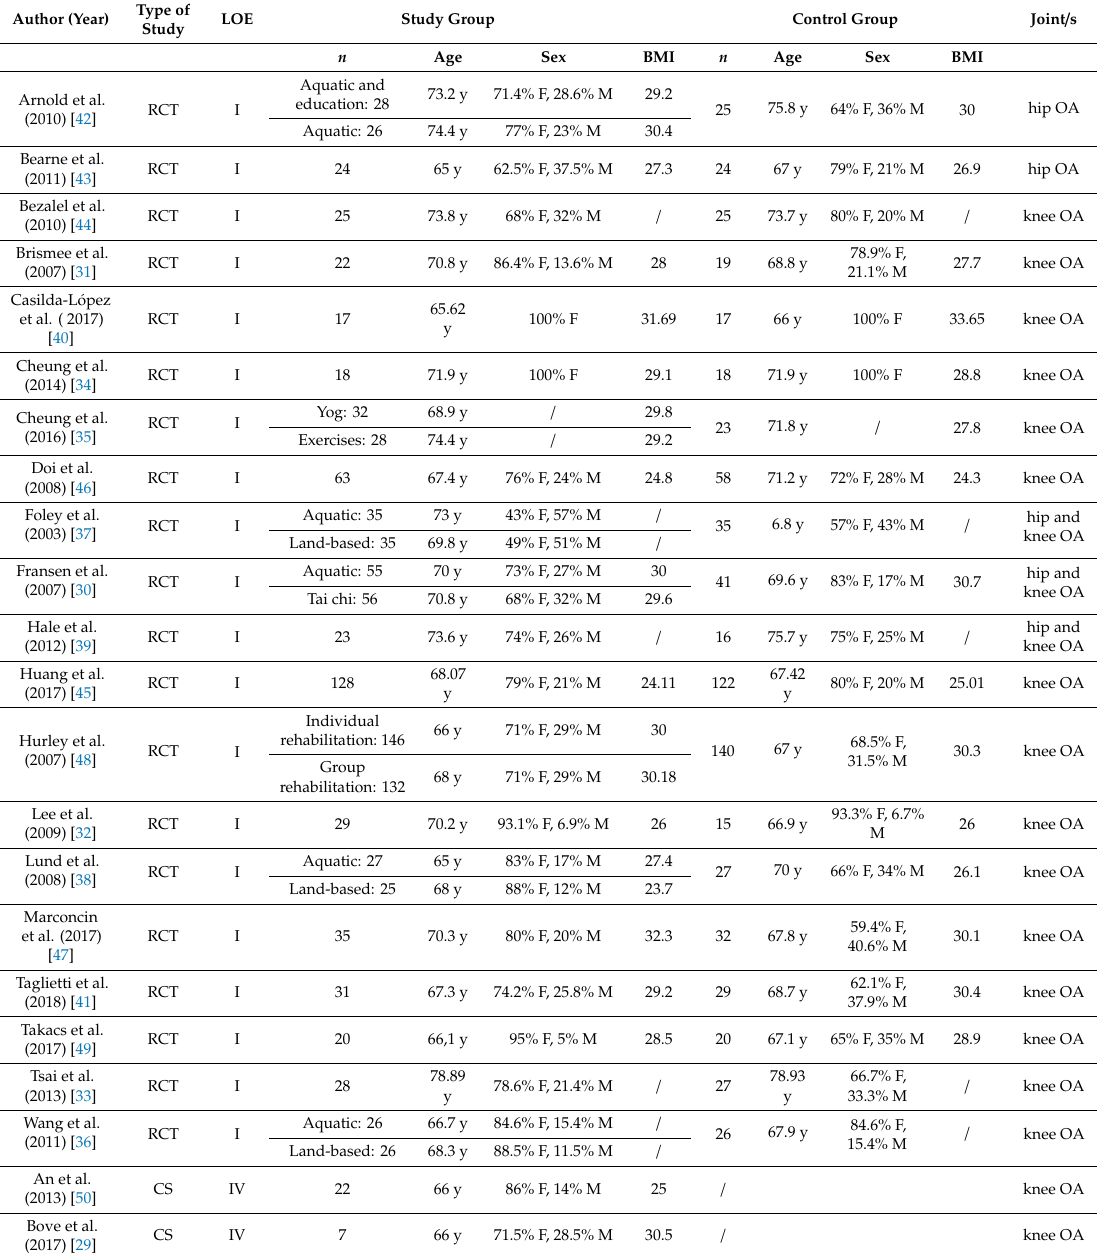
Table 1. Demographic data of the included